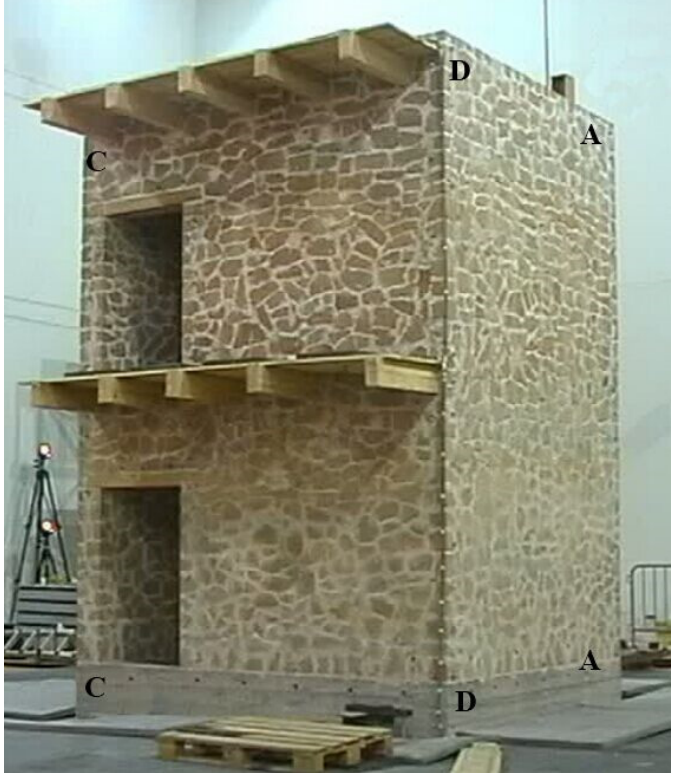
Figure 1. View of the unreinforced masonry (URM) prototype.